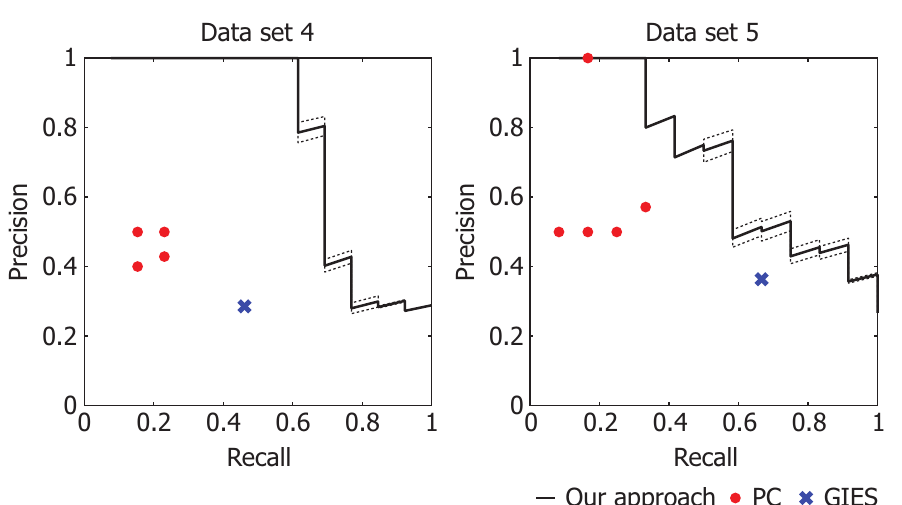
Fig 5. Performance comparison with PC and GIES on DREAM4 data sets. We evaluated the final prediction accuracy of our active learning algorithm in identifying edges in the undirected skeleton of the ground truth network. The resulting precision-recall (PR) curves were compared to PC with different values of α (significance level) in {0.01, 0.05, 0.1, 0.2, 0.3} using only observational data and to GIES using both observational and intervention data. We used the implementations of PC and GIES provided in the pcalg package in R. The dashed lines are drawn at one standard deviation from the mean in each direction based on five random trials. Our performance generally dominates that of PC and GIES, suggesting the effectiveness of our Bayesian learning approach.